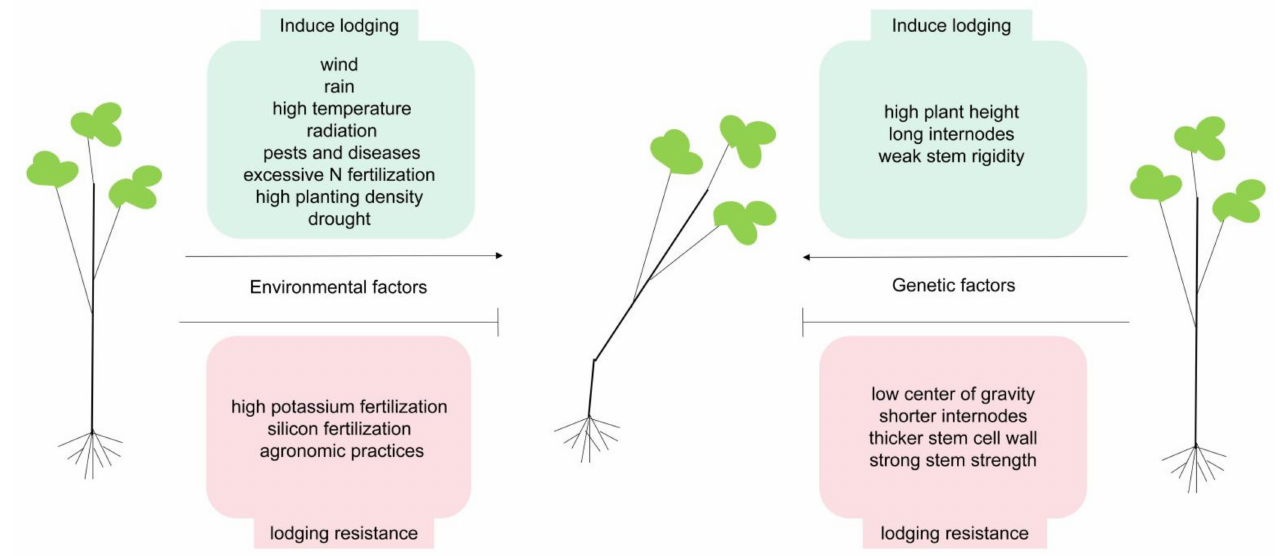
Figure 1. Factors affecting stem lodging. The arrow means induction factors. The short line shows the lodging resistance